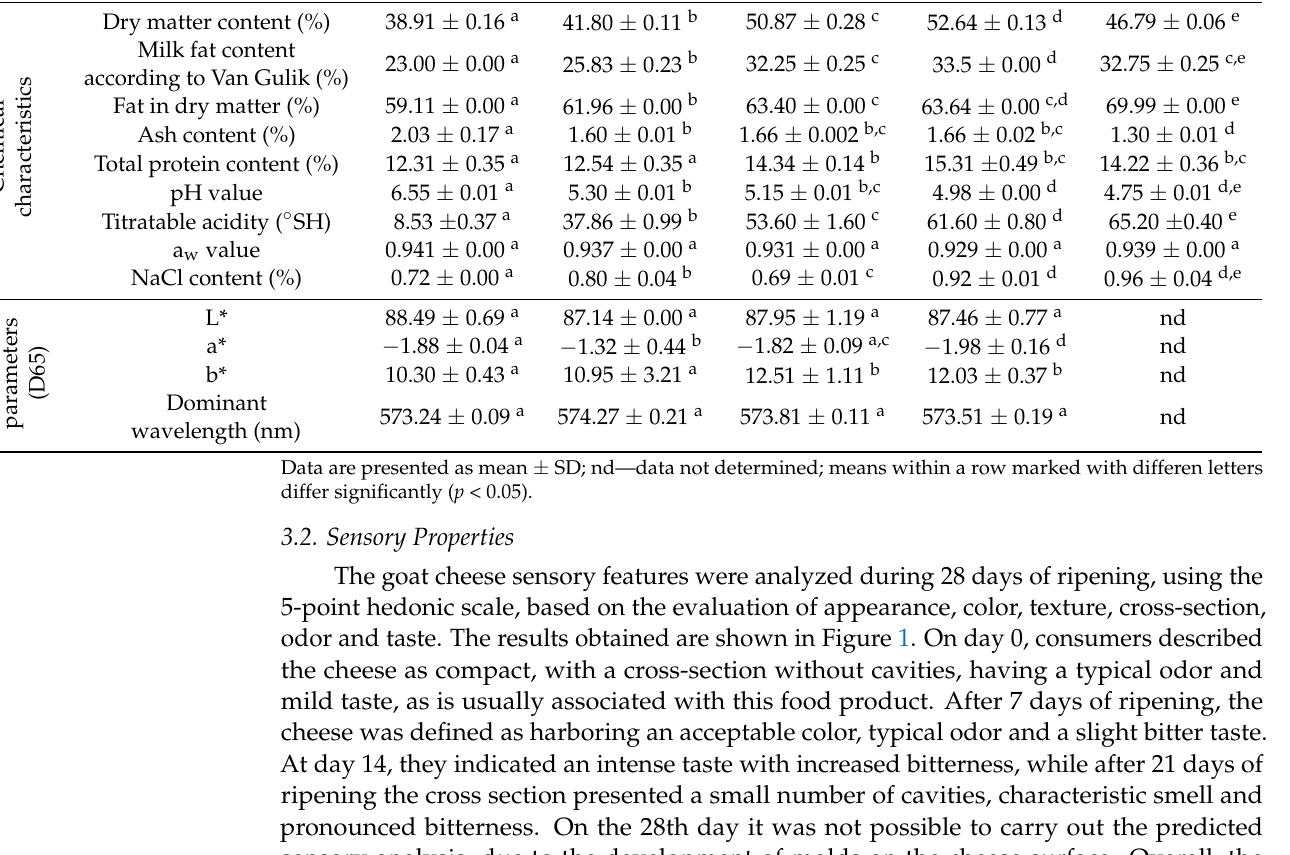
Table 2. Physico- chemical parameters of goat’s cheese during ripening.